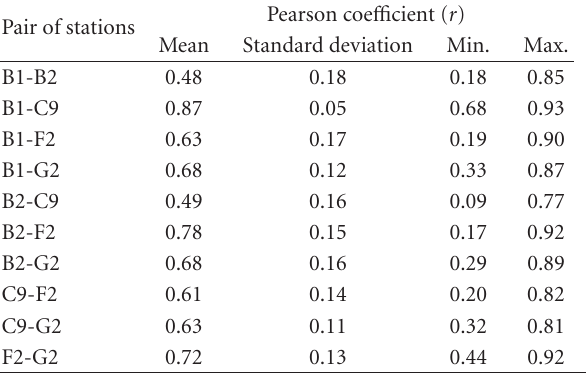
Table 7: Correlations of ozone levels between the five air monitor- ing stations during ozone episodes, using the Pearson correlation coe ffi cient r . Periods containing less than 80% of the total data were withdrawn from the